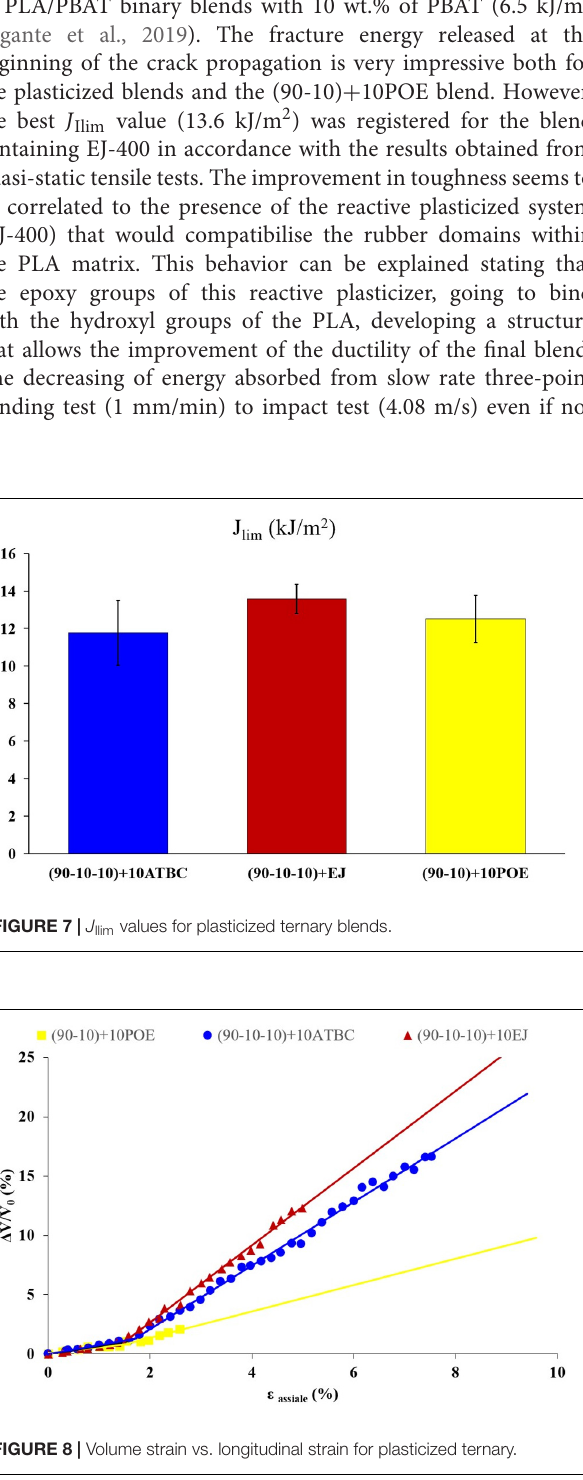
FIGURE 8 | Volume strain vs. longitudinal strain for plasticized ternary.